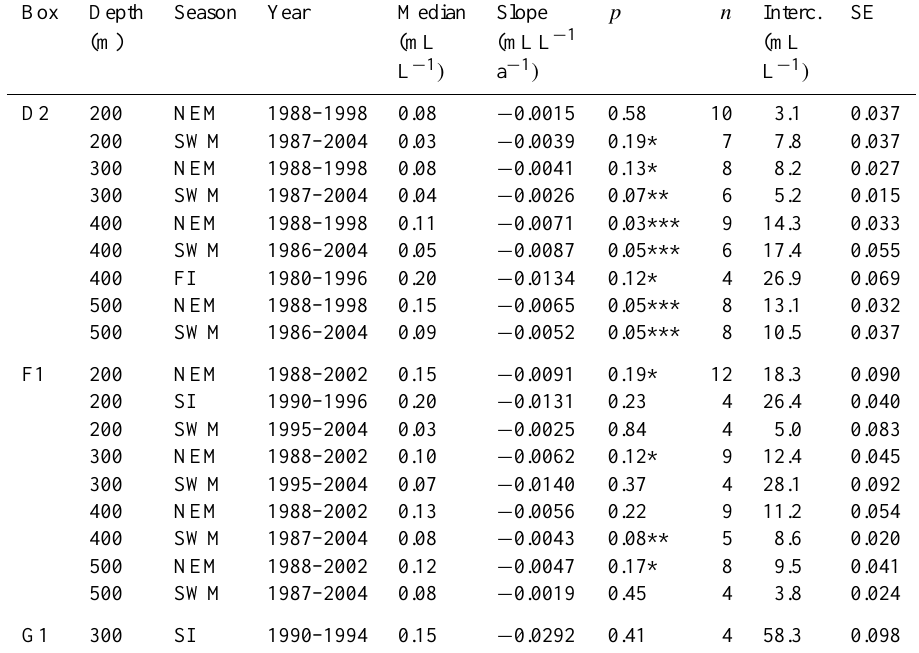
Table 6. Medians with slopes and intercepts of seasonal regressions of O 2 on year in the OMZ without 1960s with ≥ 4 values during similar periods. p : * ≤ 0.20; ** ≤ 0.10; *** ≤ 0.05; n number of values; SE Standard Error of regression. See Fig. 3 for names of seasons and